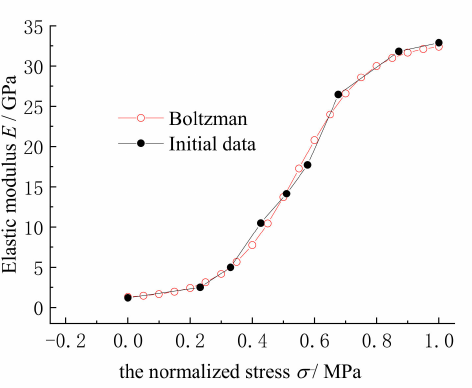
Figure 12. Data fitting for the relationship between normalized stress and elastic modulus.